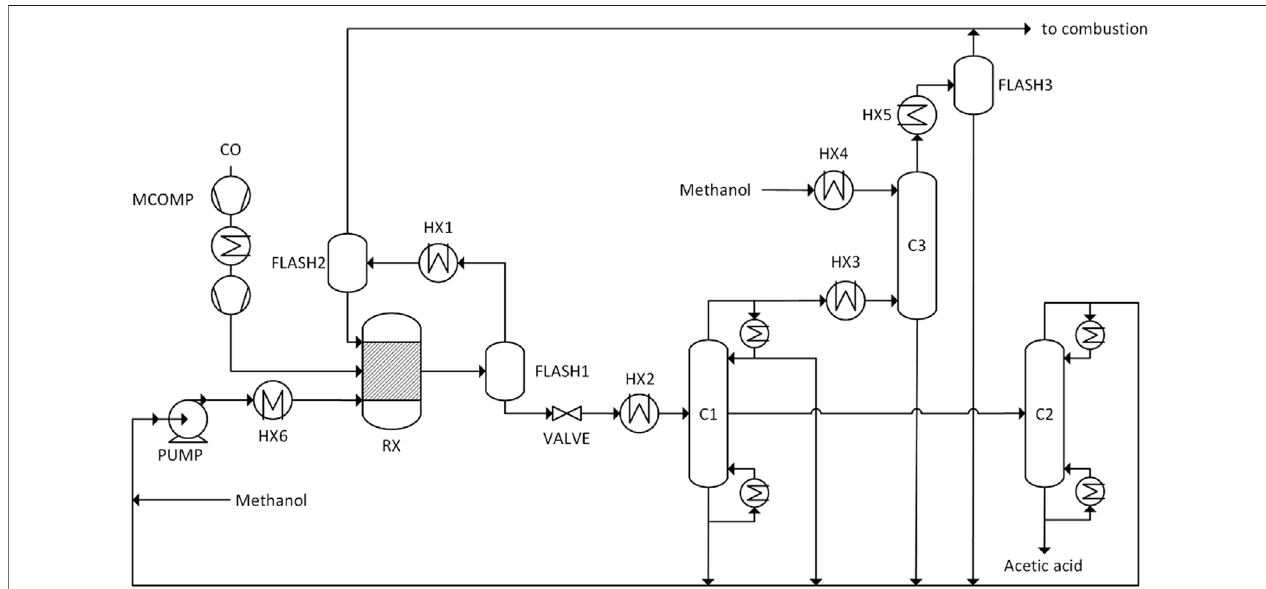
FIGURE 4 | Flowsheet of the Cativa process for the production of acetic